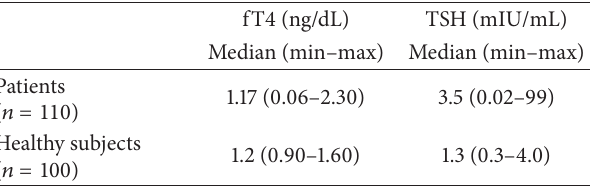
Table 1: The laboratory findings of patients and control